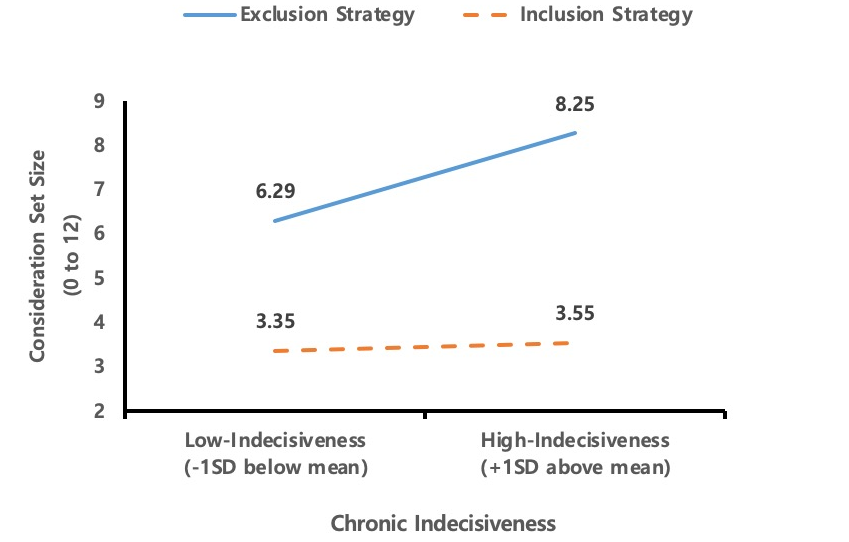
<Figure 2> Study 1: Consideration Set Size (Spotlight